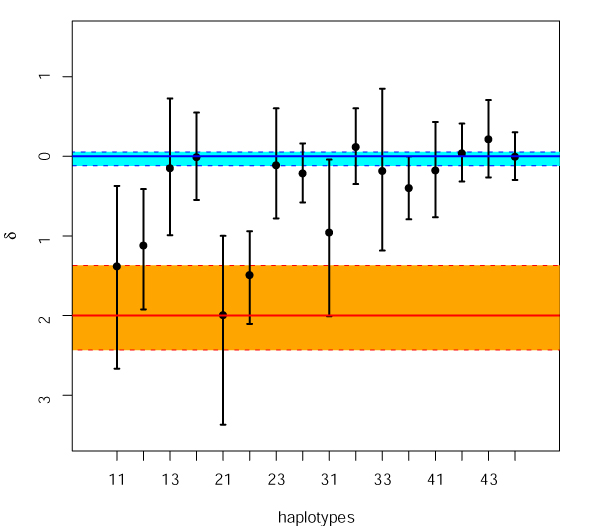
Separately simulated data modelled on Danacaa replicate 2, D01S023–D01S024. Estimated posterior means and 95% confidence intervals for the effects of individual haplotypes for both CAR (16 individual haplotype effects) and Potts models (correctly estimated two clusters represented by the orange area for the haplotypes 11, 12, 21, and 22, and by the blue area for the rest). The true simulated values of δ = (-2, 0) are shown by solid red and blue lines respectively.